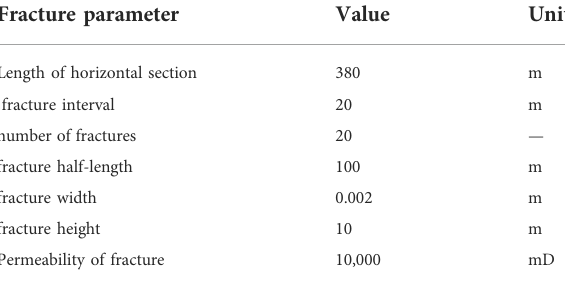
TABLE 3 Fracture parameters of fractured horizontal